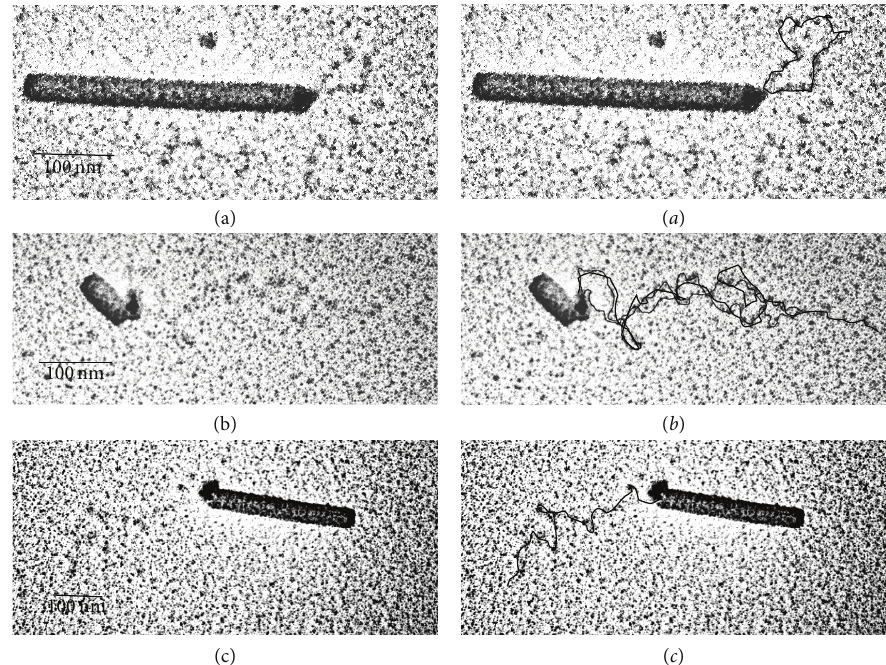
Figure 4: Partial uncoating of TMV and Pt-NPs complexes by 6 M urea. Uncoating was allowed to proceed at 0 ∘ C for 5min in 6M urea and 60mM sodium phosphate at a virus concentration of 0.5mg/mL. Shadowed samples (see Section 2) were examined with a Jeol JEM1011 microscope. Analysis was conducted on 130 uncoated partially TMV particles. Left: ((a), (b)) show a loop of the free RNA released from TMV particle retained by Pt nanoparticle and (c) shows the partially hydrolyzed linear RNA. It is important to note that RNA has secondary structure under spreading conditions. Right: (( a )–( c )) merge images with inked over RNA